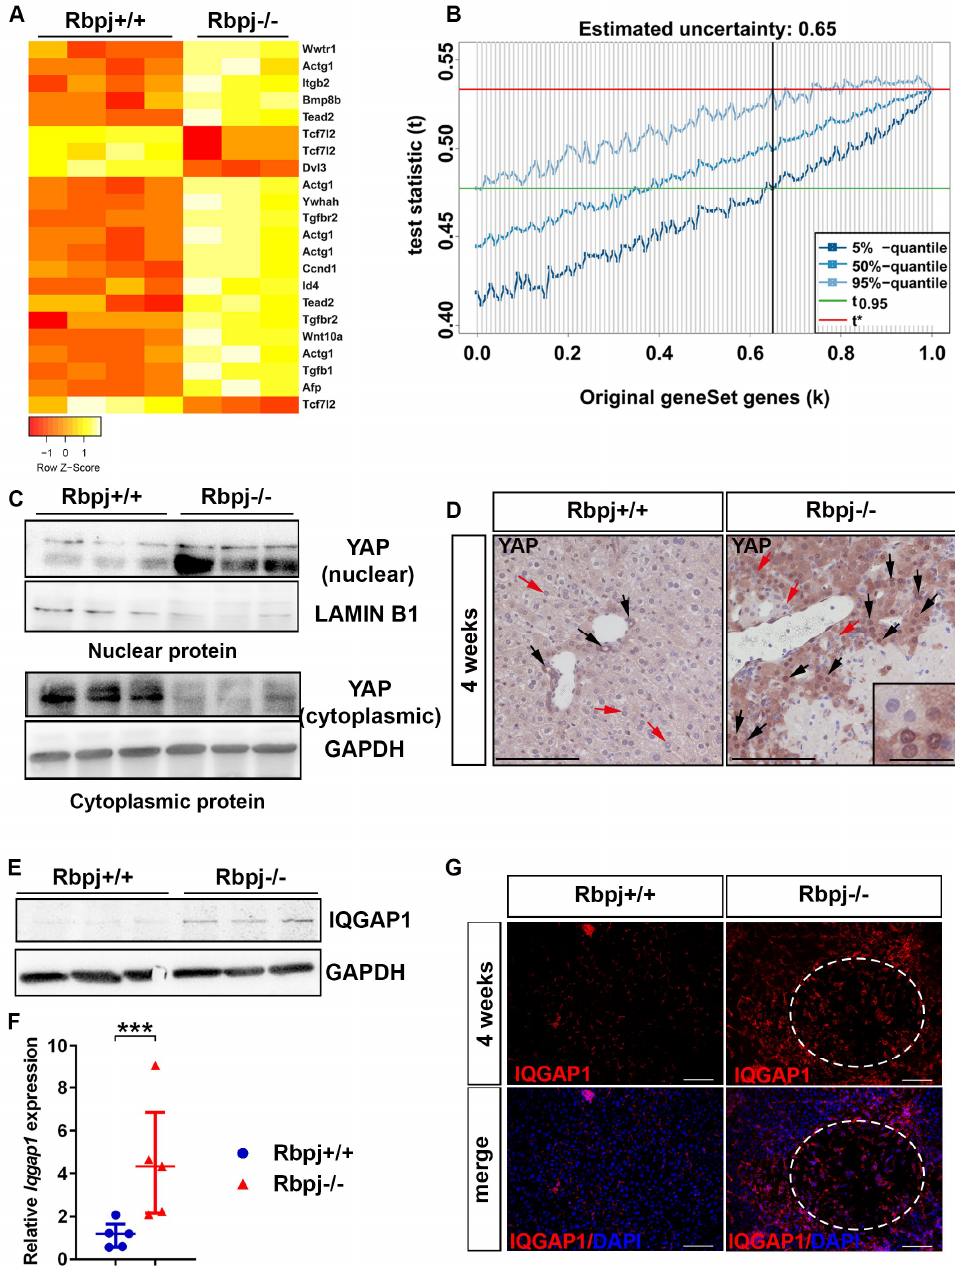
Figure 5. Notch-pathway deficiency induced cholestasis results in YAP activation and deregulation of the Hippo-pathway gene set. ( A ) Heatmap of differentially regulated genes of the Hippo pathway between 4-week-old Rbpj +/+ and Rbpj −/− mice ( n = 3–4). ( B ) GiANT of the Hippo pathway gene set in 4-week-old murine liver, which quantified the uncertainty in the Hippo pathway ( n = 3) (t: test statistic of interest; t*: value statistic of the original gene set; k: tested degree of uncertainty). ( C ) Immunoblot of nuclear and cytoplasmic YAP in the liver of Rbpj +/+ and Rbpj −/− mice. ( n = 3). Full-length immunoblots are depicted in Figure S5A,B ( D ) YAP immunostaining showed increased nuclear staining of YAP in Rbpj −/− hepatocytes ( n = 5; scale bar: 100 µm (inlet shows expanded view of a particular region of the original image, scale bar: 25 µm)); black arrows represent nuclear YAP + cells and red arrow represents nuclear YAP - cells). ( E ) Immunoblot of IQGAP1 of whole liver protein lysates ( n = 3). Full-length immunoblot is depicted in Figure S5D. ( F ) Relative mRNA expression of Iqgap1 normalised to RNA polymerase II ( n = 5; *** p ≤ 0.001, Mann–Whitney test (Two tailed)). ( G ) Representative photographs of IQGAP1-IF (red fluorescence signals depict IQGAP1 expression, upper panel) and IQGAP1-IF with nuclear DAPI stain (lower panel, merged) of Rbpj +/+ and Rbpj − / − liver. Necrotic area is circled by white dots ( n = 3; scale bar: 100 µ